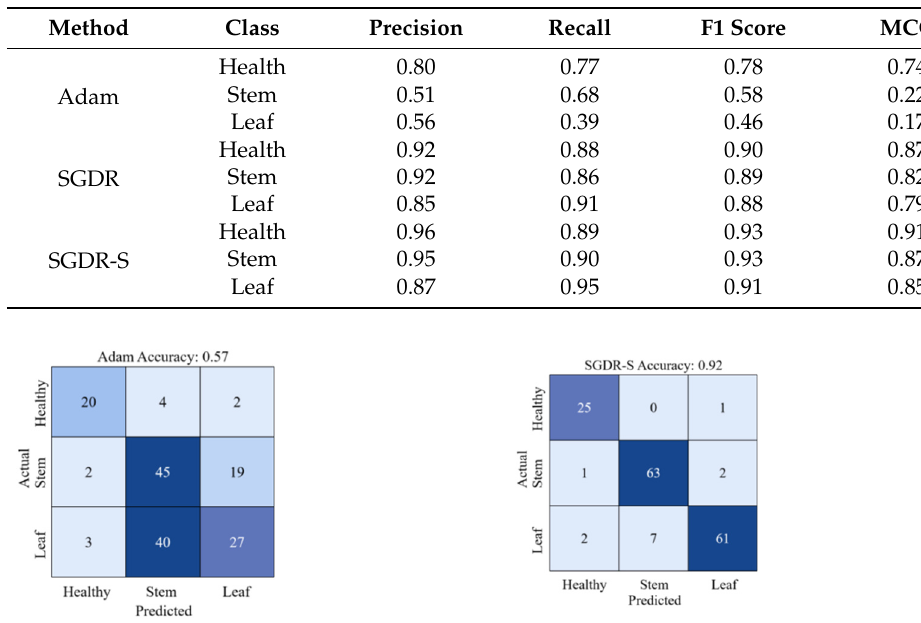
Table 1. Performance of the Adam, SGDR, and SGDR-S algorithms.